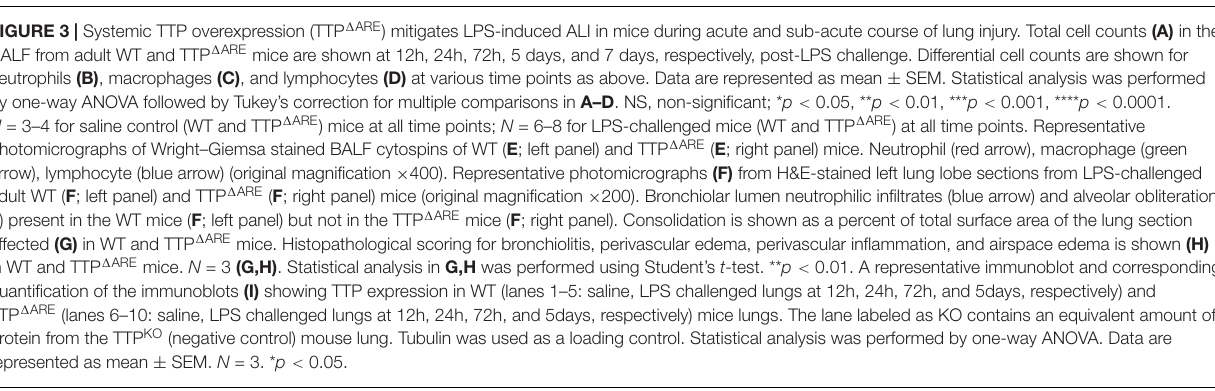
FIGURE 3 | Systemic TTP overexpression (TTP (cid:49) ARE ) mitigates LPS-induced ALI in mice during acute and sub-acute course of lung injury. Total cell counts (A) in the BALF from adult WT and TTP (cid:49) ARE mice are shown at 12h, 24h, 72h, 5 days, and 7 days, respectively, post-LPS challenge. Differential cell counts are shown for neutrophils (B) , macrophages (C) , and lymphocytes (D) at various time points as above. Data are represented as mean ± SEM. Statistical analysis was performed by one-way ANOVA followed by Tukey’s correction for multiple comparisons in A–D . NS, non-significant; * p < 0.05, ** p < 0.01, *** p < 0.001, **** p < 0.0001. N = 3–4 for saline control (WT and TTP (cid:49) ARE ) mice at all time points; N = 6–8 for LPS-challenged mice (WT and TTP (cid:49) ARE ) at all time points. Representative photomicrographs of Wright–Giemsa stained BALF cytospins of WT ( E ; left panel) and TTP (cid:49) ARE ( E ; right panel) mice. Neutrophil (red arrow), macrophage (green arrow), lymphocyte (blue arrow) (original magnification × 400). Representative photomicrographs (F) from H&E-stained left lung lobe sections from LPS-challenged adult WT ( F ; left panel) and TTP (cid:49) ARE ( F ; right panel) mice (original magnification × 200). Bronchiolar lumen neutrophilic infiltrates (blue arrow) and alveolar obliteration (*) present in the WT mice ( F ; left panel) but not in the TTP (cid:49) ARE mice ( F ; right panel). Consolidation is shown as a percent of total surface area of the lung section affected (G) in WT and TTP (cid:49) ARE mice. Histopathological scoring for bronchiolitis, perivascular edema, perivascular inflammation, and airspace edema is shown (H) in WT and TTP (cid:49) ARE mice. N = 3 (G,H) . Statistical analysis in G,H was performed using Student’s t -test. ** p < 0.01. A representative immunoblot and corresponding quantification of the immunoblots (I) showing TTP expression in WT (lanes 1–5: saline, LPS challenged lungs at 12h, 24h, 72h, and 5days, respectively)